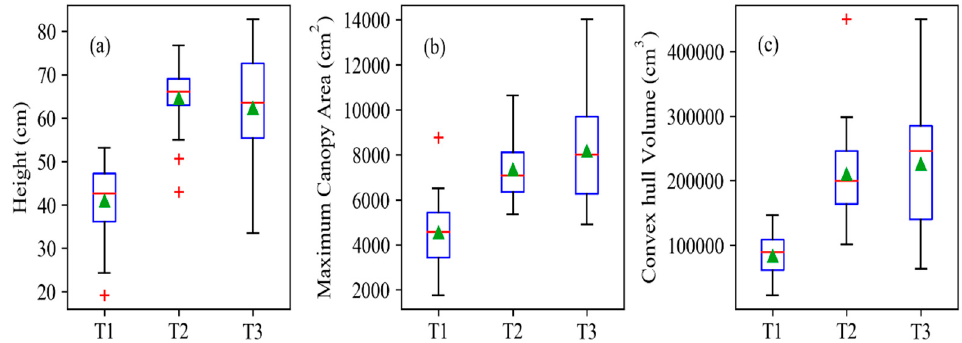
Figure 12. Distribution of extracted ( a ) plant height, ( b ) maximum canopy area and ( c ) convex hull volume values for sugar beet plants at T1, T2 and T3 stages. The box boundaries represent the 25th and 75th percentiles. Green triangles represent means and red lines represent medians. Red crosses are outliers and the whiskers represent the extreme values of the point cloud.